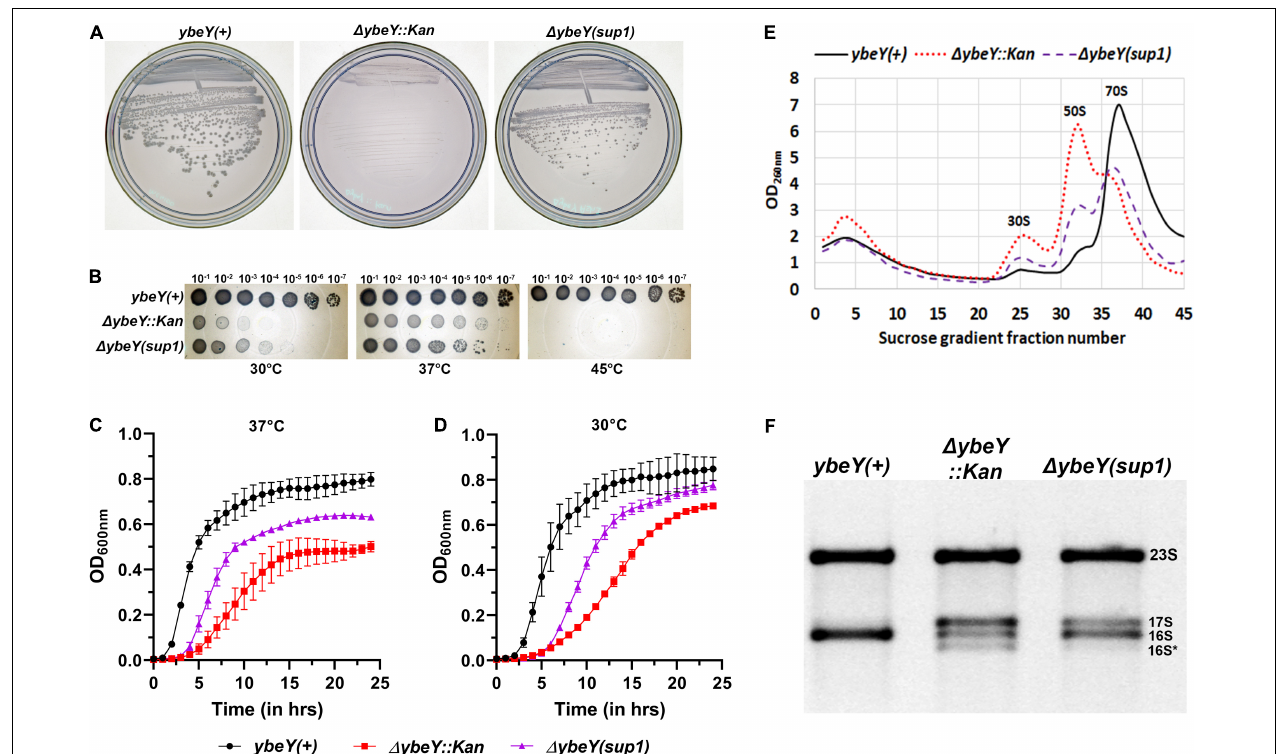
FIGURE 1 | Characterization of the suppressed (cid:49) ybeY isolate. (A) Strains from freezer stocks were streaked onto LB agar plates and then incubated at 37 ◦ C overnight. Plates were imaged separately. An increase in colony formation and colony diameter was observed in the (cid:49) ybeY(sup1) strain compared to the (cid:49) ybeY::Kan strain. (B) Tenfold serial dilutions of the overnight cultures were spotted onto LB agar plates and incubated at the indicated temperatures overnight. Representative sections of the imaged plates are shown. (C,D) Growth curves of the strains ybeY + (black, circles), (cid:49) ybeY(sup1) (purple, triangles), and (cid:49) ybeY::Kan (red, squares) in liquid LB media were determined at 37 ◦ C (C) or 30 ◦ C (D) by measuring optical density (OD) at 600 nm in a plate reader for 24 h. The average ± SD of three determinations is shown. (E) Total cell lysate of the strains ybeY + (black, continuous line), (cid:49) ybeY(sup1) (purple, broken line), and (cid:49) ybeY::Kan (red, dotted line), separated by sucrose gradients and the amount of RNA in each fraction was determined by measuring absorbance at 260 nm. (F) Total RNA samples were separated on a Synergel-agarose gel by electrophoresis. Section of the representative gel image with 23S and 16S bands is